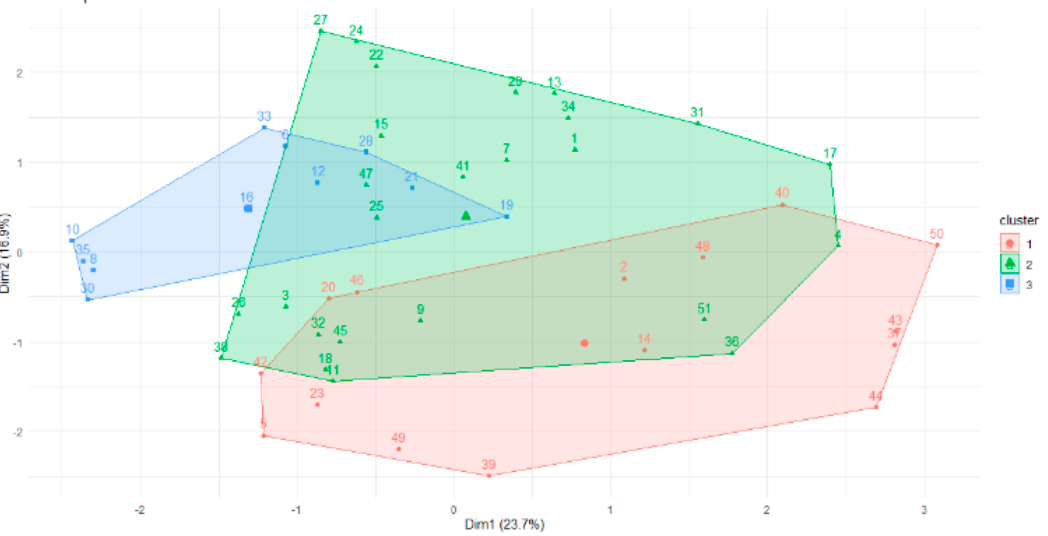
Figure 3. Applying the k-means method to determine the distribution of elements between clusters.